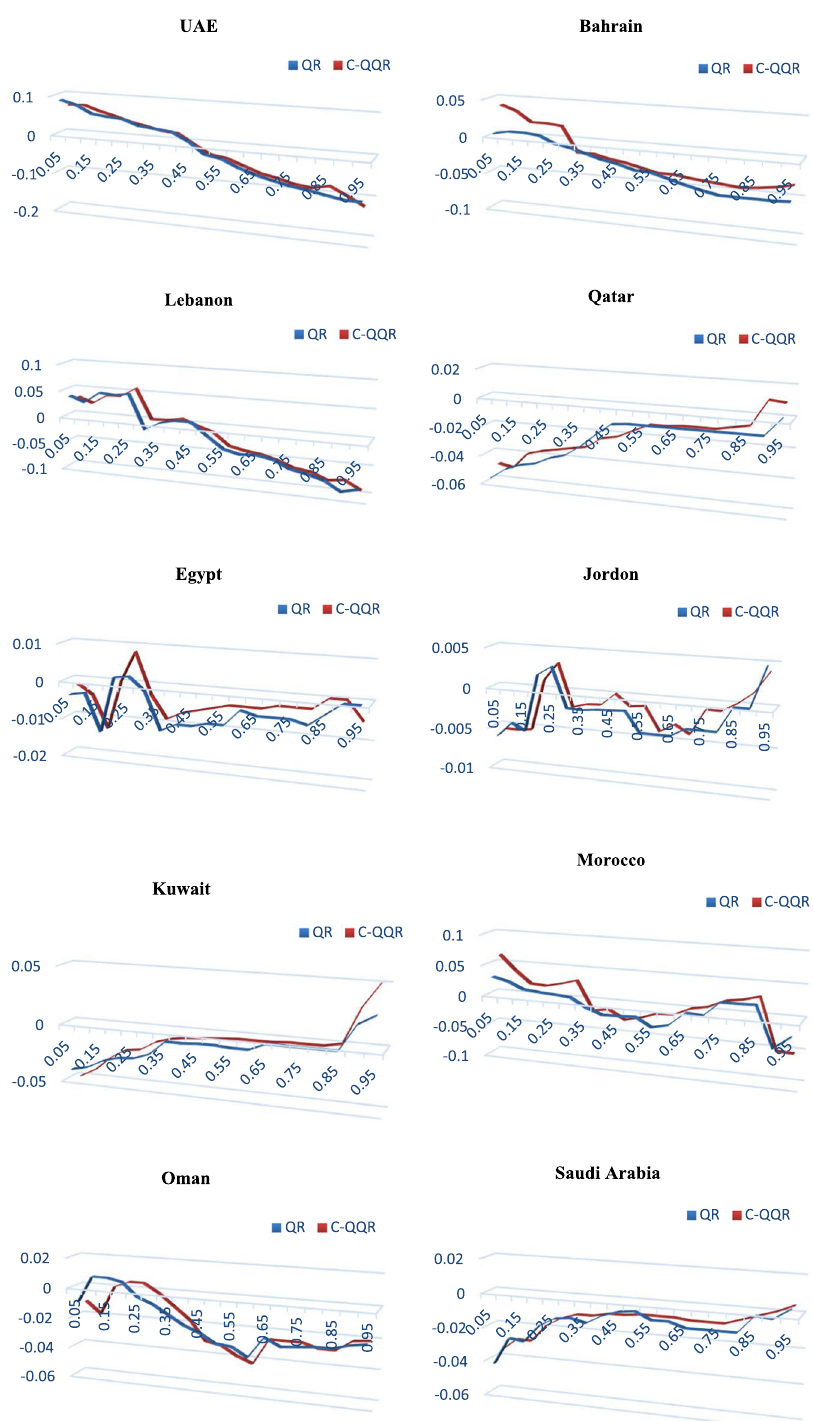
Fig. 4 Copula quantile-on-quantile (C-QQR) versus quantile regression analysis (QRA) between MENA gold and stock